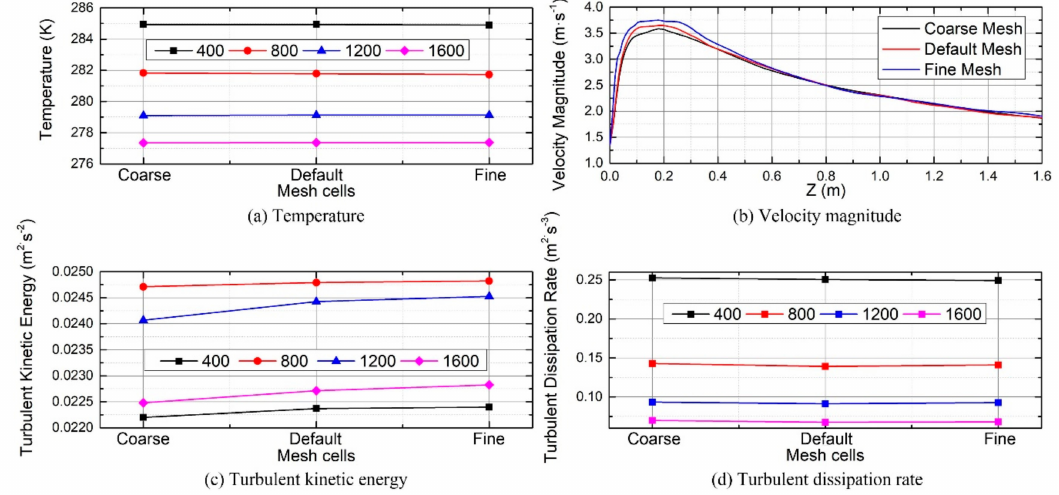
Figure 5. Mesh independence